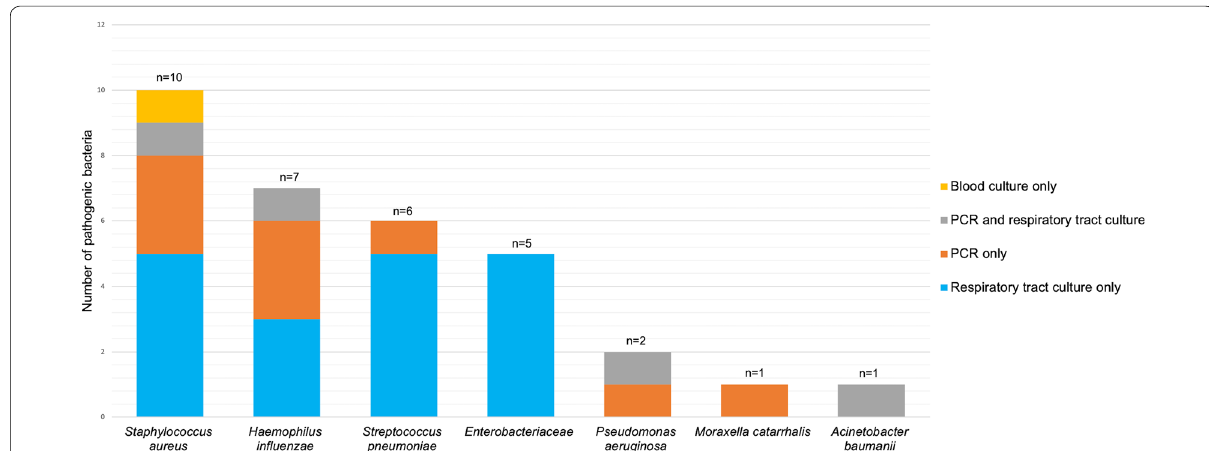
Fig. 1 Number of each species of bacteria isolated from respiratory tract cultures (blue), multiplex PCR (red), both (grey) or blood culture (yellow) among 26 critically ill patients with severe SARS-CoV-2